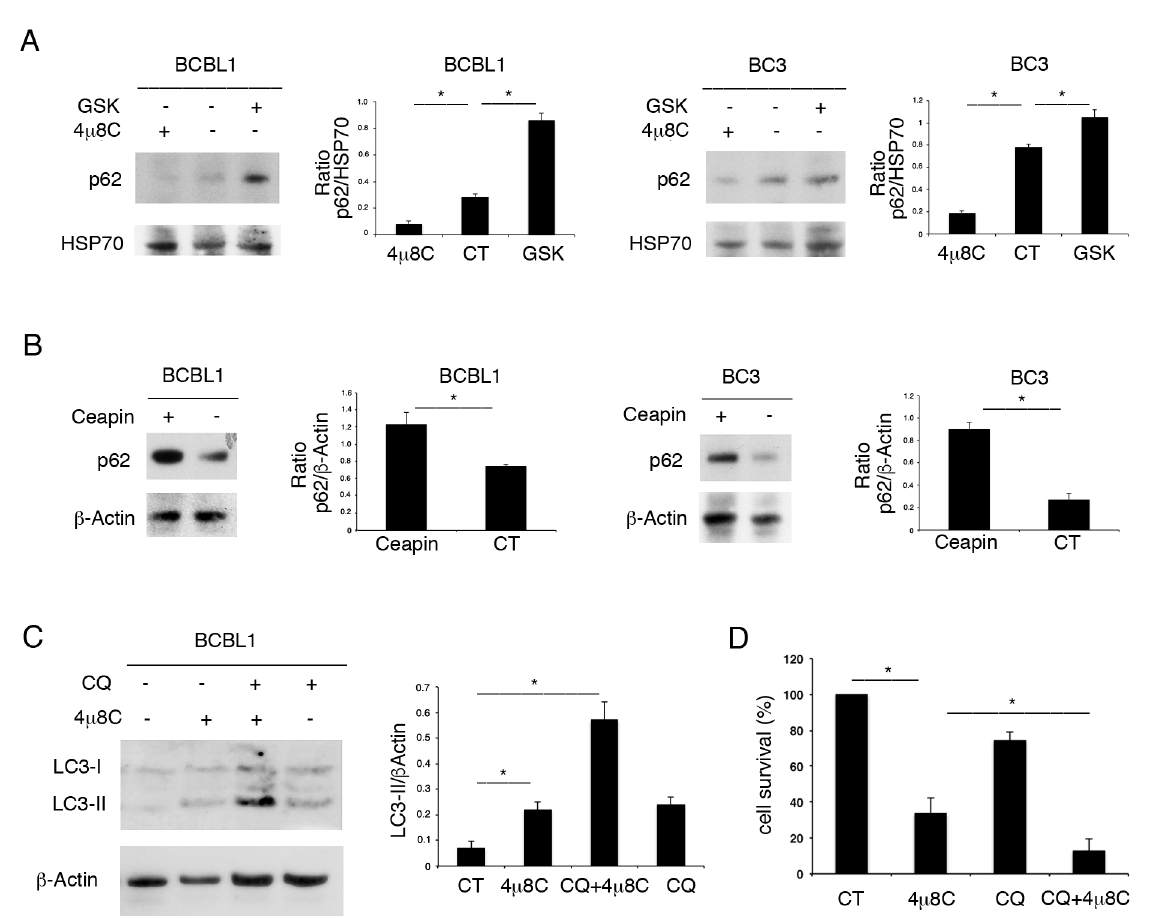
Figure 3. 4µ8C promotes a pro-survival autophagy in PEL cells. ( A ) BC3 and BCBL1 cells were treated with 4µ8C or with GSK2606414 (GSK) or ( B ) with Ceapin and p62/SQSTM1 (p62) expression level was evaluated by Western blot. ( C ) LC3I/II was evaluated by Western blot analysis in BCBL1 PEL cells treated by 4µ8C in the presence or in the absence of the autophagy inhibitor Cloroquine (CQ). A representative experiment is shown. Histograms represent the mean plus SD of the densitometric analysis of three independent experiments. * p -value < 0.05. ( D ) Cell survival was evaluated by trypan blue exclusion assay in PEL cells treated by 4µ8C in the presence or in the absence of the autophagy inhibitor Cloroquine. Histograms represent the mean plus SD of three independent experiments. * p -value < 0.05.